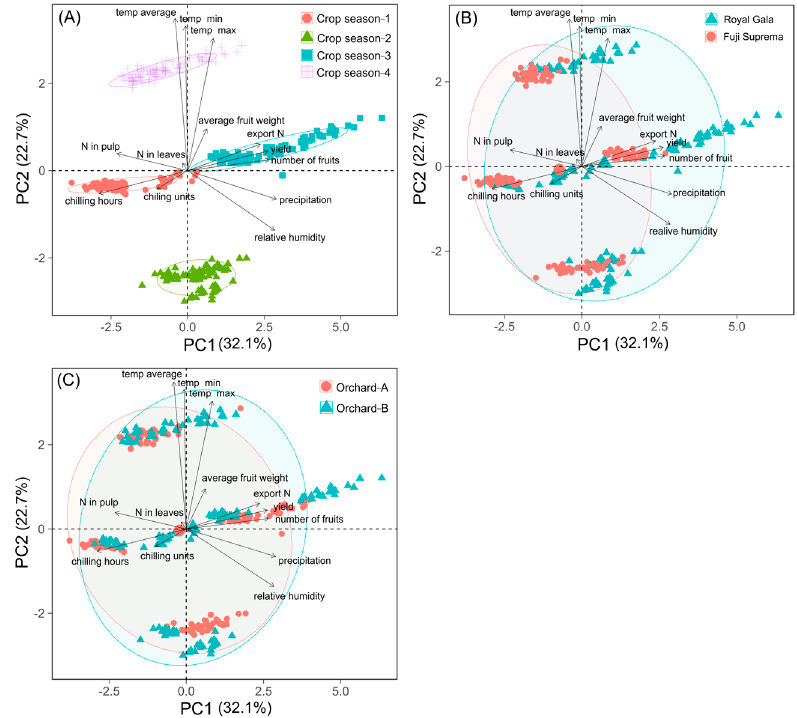
Figure 4. Relationship between the principal component 1 (PC1) and the principal component 2 (PC2) for yield and N concentrations in leaves and fruit pulp, in relation with crop season ( A ), apple cultivar ( B ) and orchard type ( C